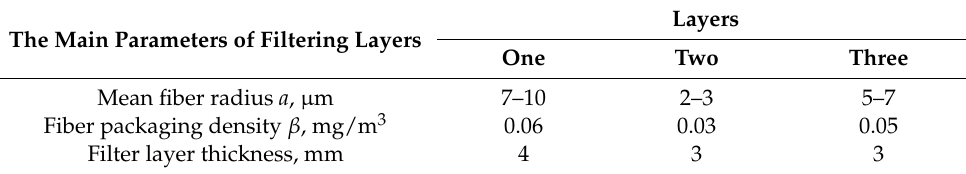
(Table 3): the first layer is protective, made from coarse fibers, the second and third layers are filtering to provide the protection level FFP2. Table 3. Characteristics of material for manufacturing FDR filtering layers.